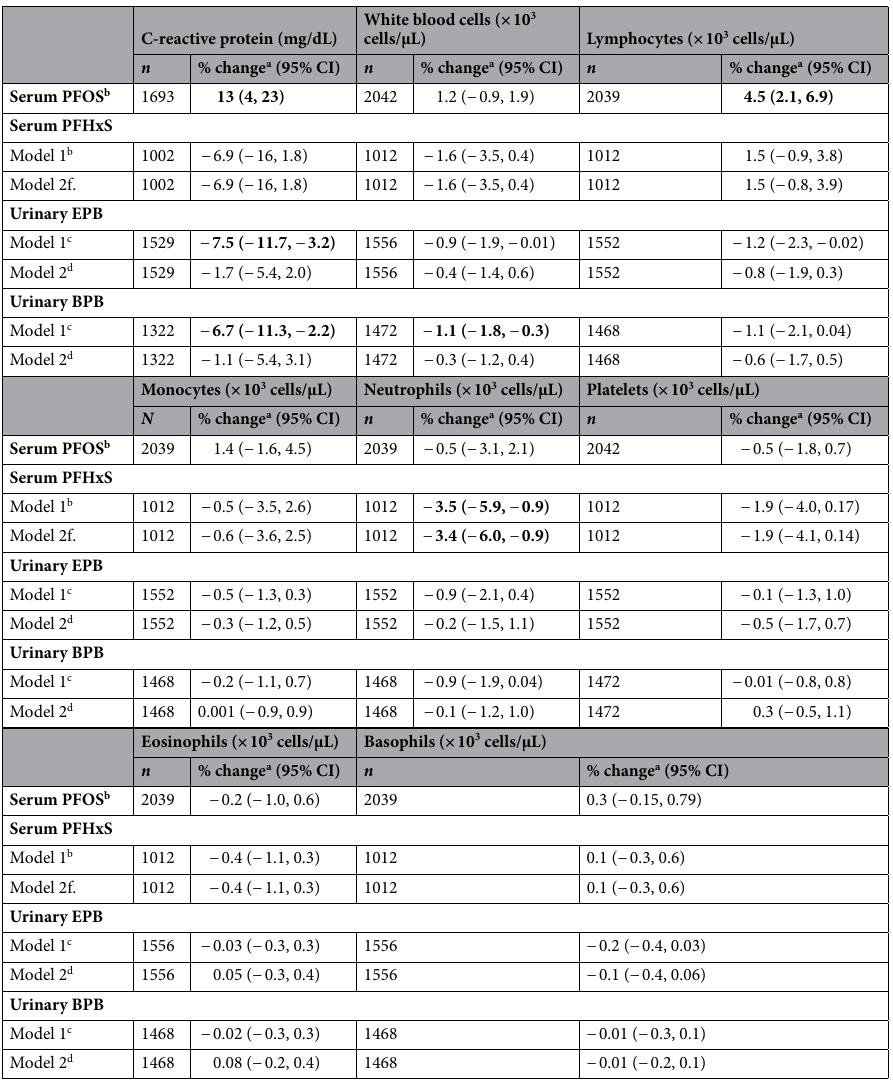
with CRP and lymphocyte count), while PFHxS was negatively associated with the absolute neutrophil count. Also consistent with our GGM findings, ethyl paraben and butyl paraben were negatively associated with inflam- mation markers in NHANES. Butyl paraben was also associated with a decrease in white blood cell count, while ethyl paraben did not affect markers of immunity. In previous cross-sectional studies, no significant associations were found between serum PFOS and CRP, and conflicting results were observed for other immune-related health conditions 40 . However, a recent prospective study has observed that elevated PFHxS concentrations at age 7 decreased anti-diphtheria and anti-tetanus antibody concentrations at age 13 41 . Parabens are widely used as antimicrobial preservatives in personal care products, pharmaceuticals, and food and beverages 42,43 . Parabens can interact with hormone receptors and have been detected in breast tissue 44,45 . Some parabens have demonstrated adverse effects on male reproduction at higher doses 46 . A previous study among pregnant women found that urinary concentrations of propyl paraben were associated with lower CRP concentrations 47 . Propyl paraben and butyl paraben have also been reported to increase the prevalence of aeroallergen sensitization in children 48,49 . The underlying mechanisms that mediate the effects of PFAS on cholesterol and glucose homeostasis, inflam- mation and immune response are thought to be related to PPAR-α,γ activation and fatty oxidation pathways 50–52 .